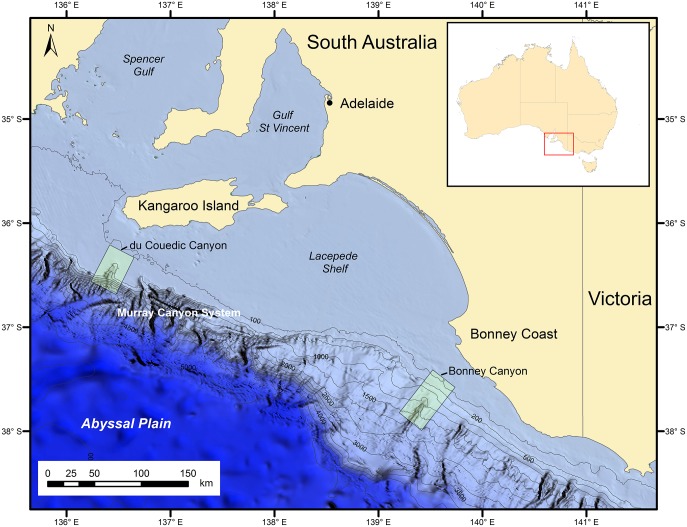
Bathymetry of the South Australian coast showing the two regions sampled (rectangles), containing the shelf-incising du Couedic Canyon to the west and the slope-confined Bonney Canyon to the east.